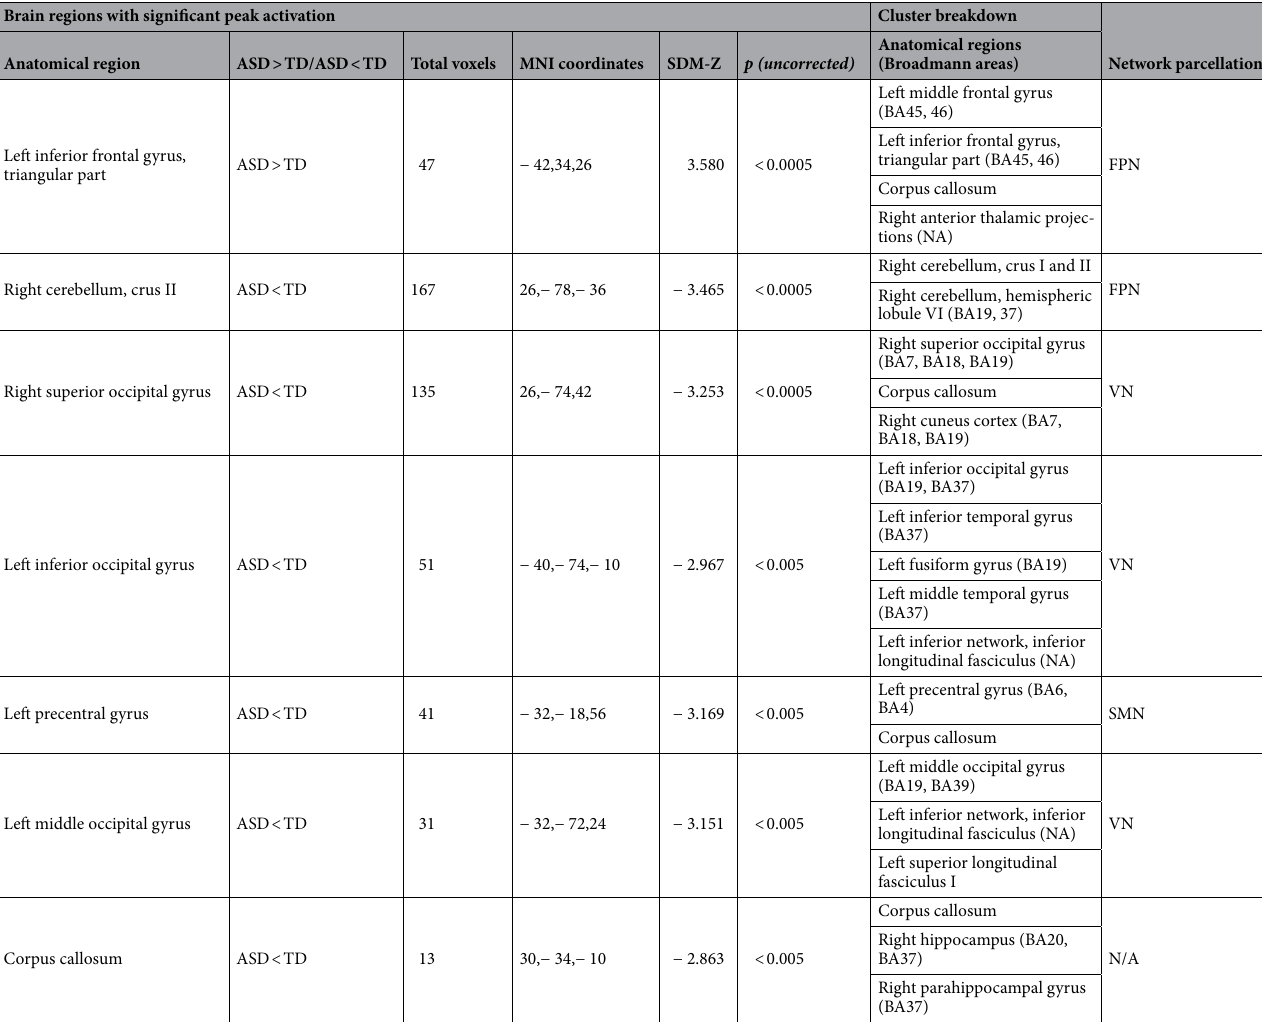
Table 5. Regarding attention and inhibitory control tasks, correlations between the changes in brain activation and age for all clusters remained nonsignificant. Regarding cognitive flexibility tasks, the activation of anterior cingulate gyri (MNI coordinates: 0,44,4), of which is was shown to be hypoactivated when compared to TD (Table 4), decreased with increasing age (SDM-Z = − 2.064; p = 0.019). Subgroup analyses with neutral stimuli only.